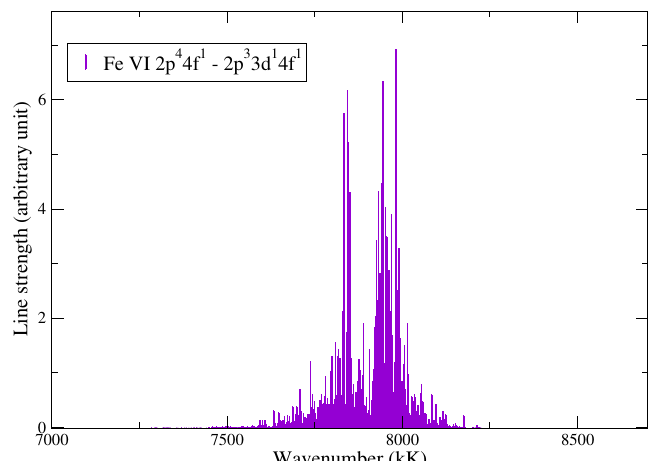
2 p 3 3 d 1 4 f 1 of Fe VI (Fe 5 + ) computed with Cowan’s code as a Figure 4. Transition array 2 p 4 4 f 1 − function of the wavenumber expressed in kiloKayser (kK): 1 kK = 1000 cm − 1 .